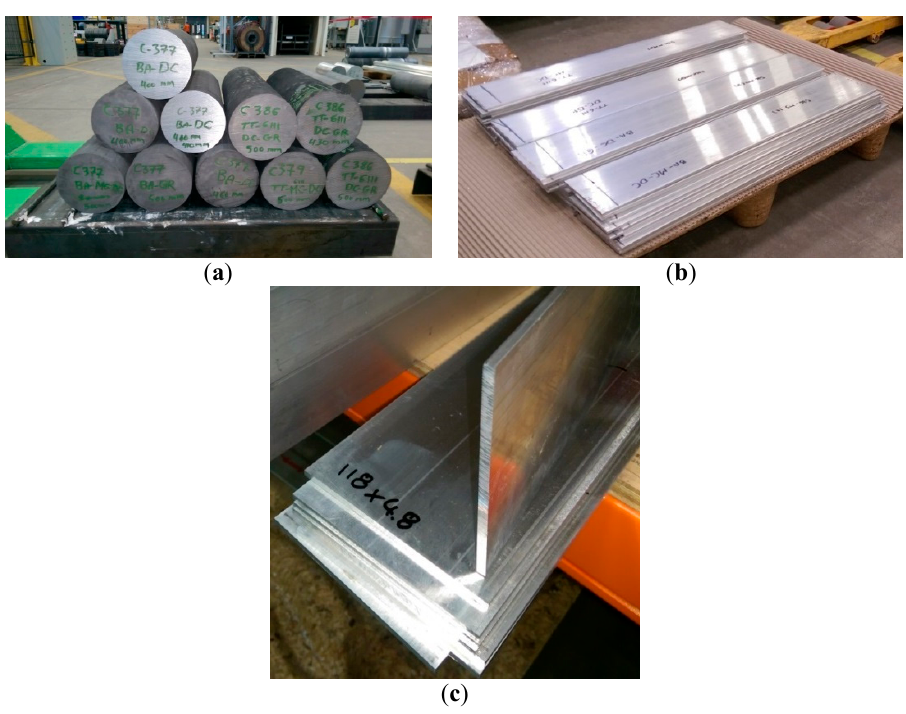
Figure 2. ( a ) Direct chill (DC), grain refined direct chill (DC-GR) and melt conditioned direct chill (MC-DC) billets, and ( b , c ) the extruded planks from DC, DC-GR and MC-DC of formulated